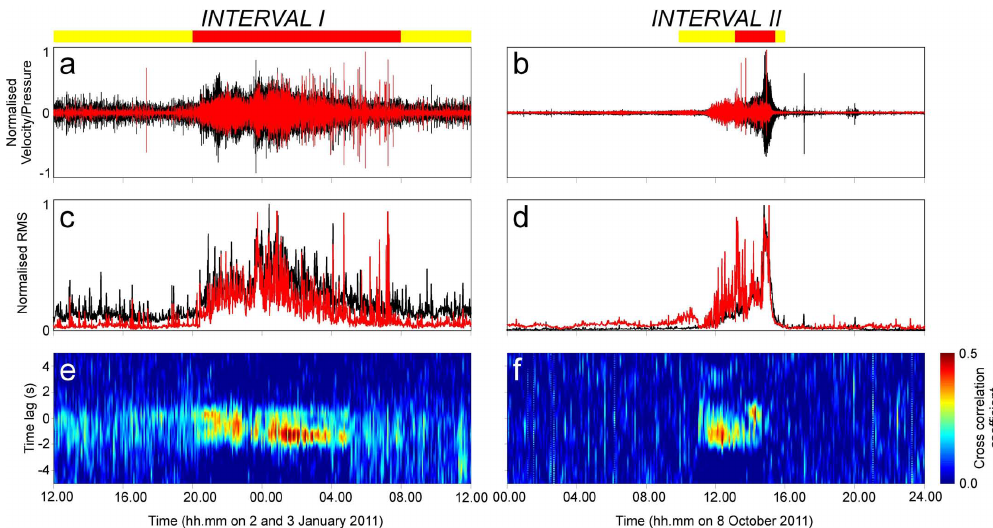
Fig. 8. (a,b) Infrasonic (red line) and seismic (black line) signals, (c,d) infrasonic (red line) and seismic (black line) RMS time series, and (e,f) corresponding cross correlation plots. (a) , (c) , and (e) refer to the time span from 12:00UTC on 2 January to 12:00UTC on 3 January, while (b) , (d) , and (f) refer to the time span from 00:00UTC to 24:00UTC on 8 October. The yellow and red rectangles at the top of (a) indicate the intervals characterised by mild and intense strombolian activity, respectively. The yellow and red rectangles at the top of (b) indicate the intervals characterised by strombolian and lava fountain activities, respectively. Negative and positive values of time lag in (e) and (f) signify that seismic signals precede and follow the infrasonic ones,